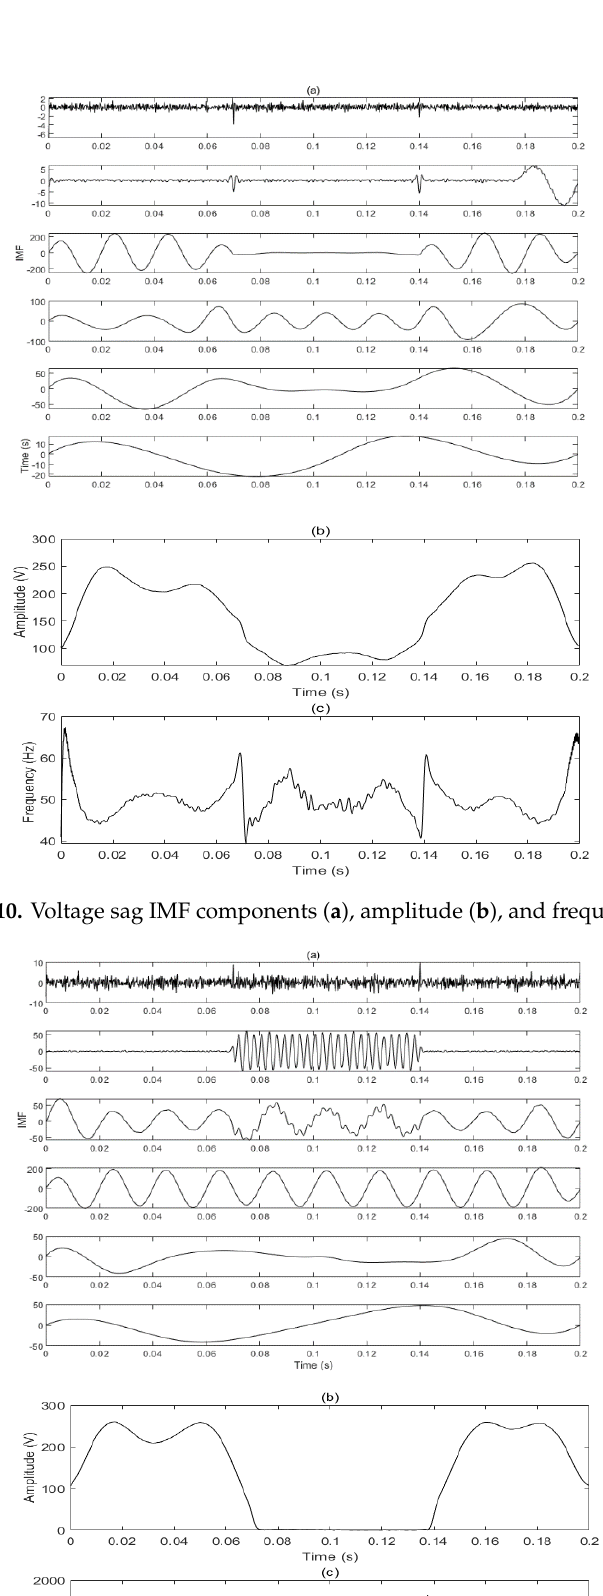
Figure 9. Voltage swell IMF components ( a ), amplitude ( b ), and frequency ( c ).